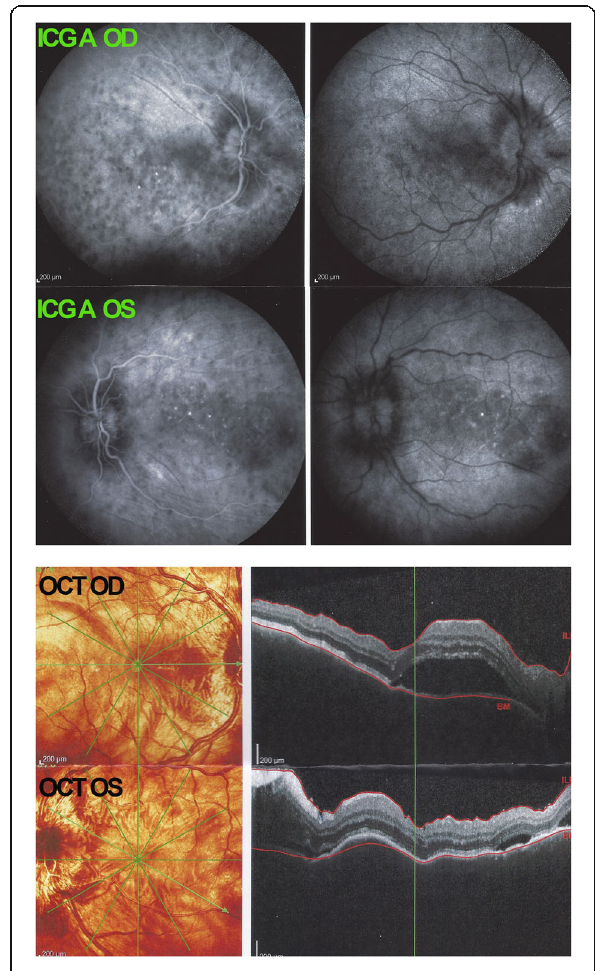
Fig. 1 Case of VKH at presentation. ICGA picture ODS shows exudative detachments and numerous HDDs. OCT shows retinal folds and subretinal fluid and very thickened choroids impossible to measure on EDI-OCT